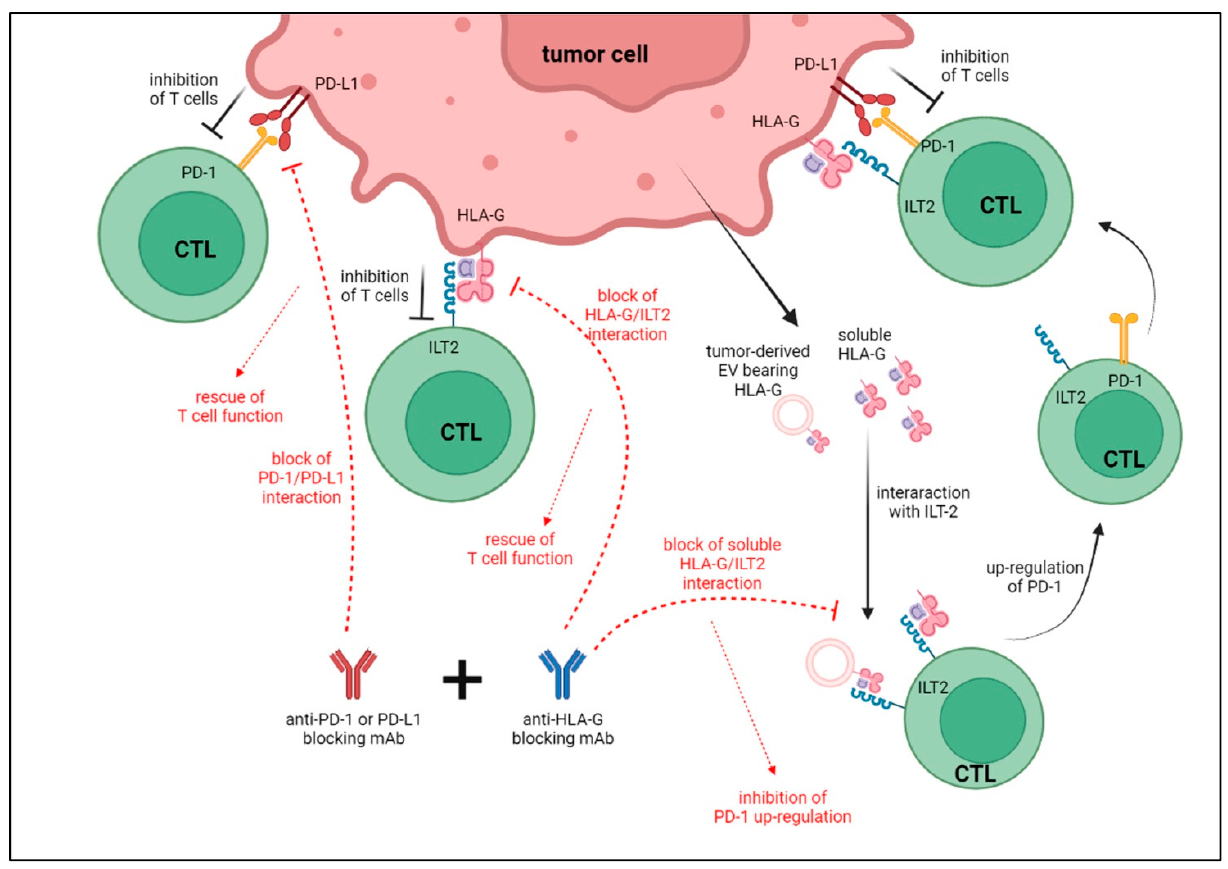
Figure 1. Schematic representation of the interactions between HLA-G and PD-1/PD-L1 and possible effects of a combined administration of anti-PD-1/PD-L1 and anti-HLA-G blocking antibodies. Table 1. Description of clinical trials based on the combination of antibodies targeting HLA-G and other immune